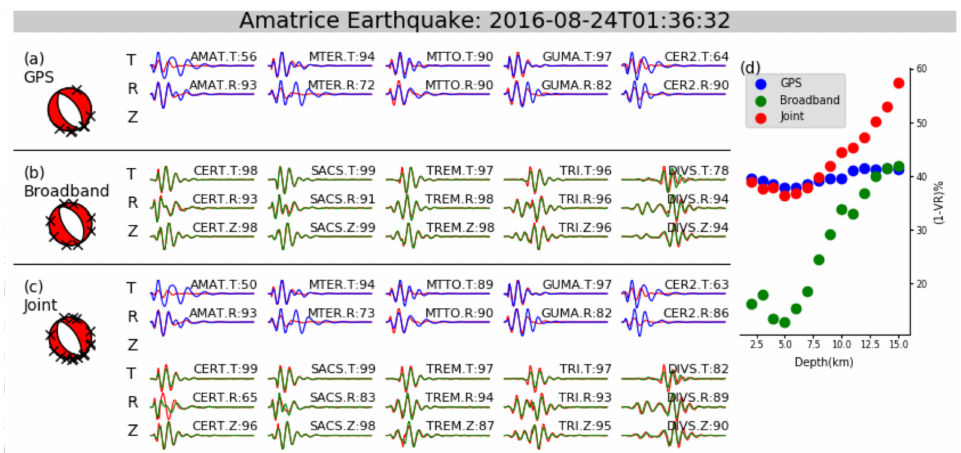
Figure 4. Inversion results of the Amatrice Earthquake. ( a – c ), focal mechanisms and comparison between the observed and synthetic seismograms of the inversion using high-rate GPS data, broadband data and both of them, respectively. Blue and green lines in ( a – c ) are observed high-rate GPS and broadband waveforms, respectively. Red lines are synthetic seismograms. Crosses on the beachballs indicate the azimuths of the stations used in the inversions. Texts upon waveforms are station names, component names and the cross-correlation coefficients. ( d ) VRs of the inversions at depth from 2 km to 15 km. As space is limited, waveforms from only five GPS stations and five broadband stations are exhibited